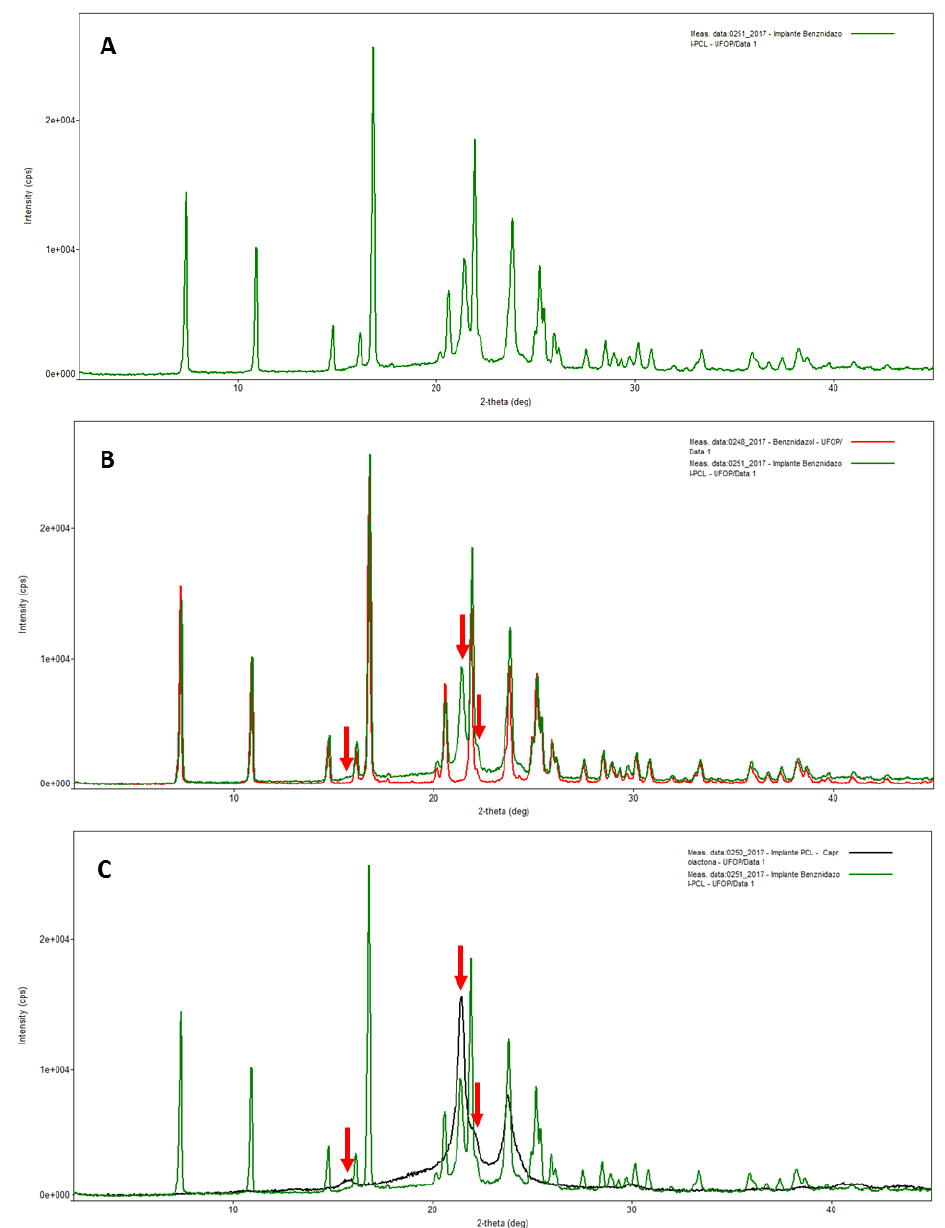
Figure 2. X-ray diffractogram of implants. ( A ) BZ – PCL implants. ( B ) BZ – PCL implants (green) and benznidazole (red). Red arrows indicate peaks that cannot be attributed to the pure drug. ( C ) BZ – PCL implants (green) and PCL implants (black). Red arrows indicate peaks that can be attributed to the diffraction profile of the implant without BZ.